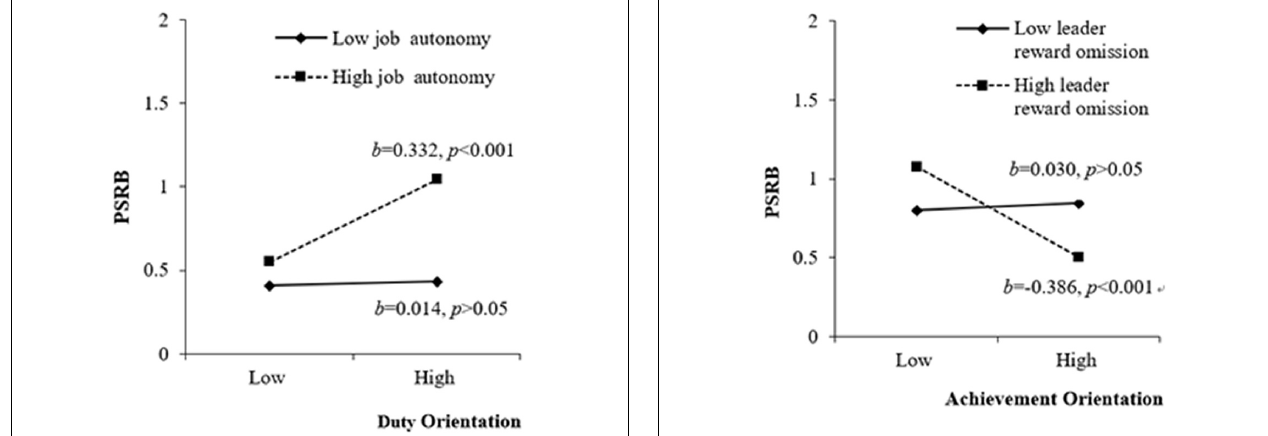
FIGURE 2 | Moderating effect of job autonomy between duty orientation and PSRB.